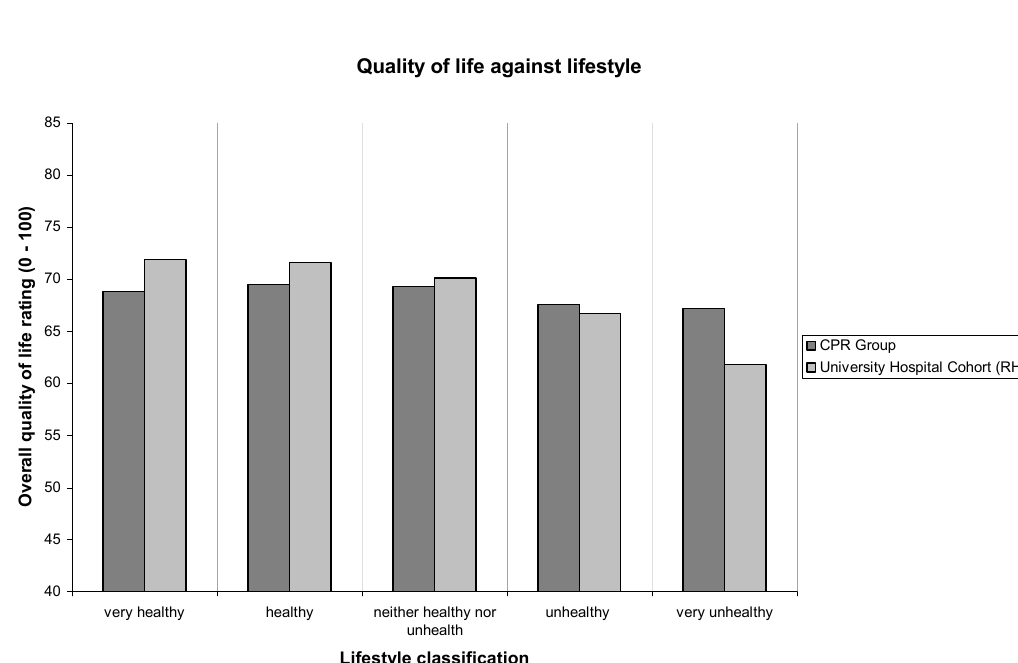
Figure 3 : Global quality of life against lifestyle. The statistical co-variation is 5-10% in the two studies. This is a far weaker co- variation than is seen between quality of life and health (Figure 2). Taken together with the week connection between lifestyle and health status (Figure 1) the results suggests that lifestyle is only weakly connected to QOL and health. To improve QOL and health more than a change in lifestyle seems to be